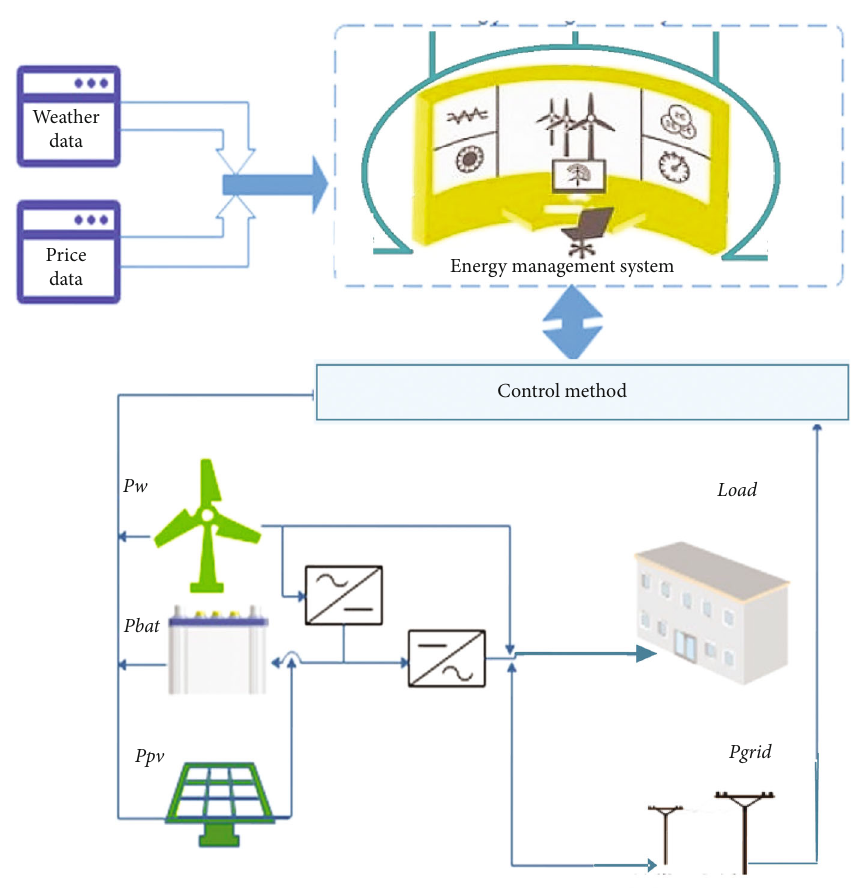
Figure 1: Structure of the proposed hybrid system. Table 1: Electricity tari ff for Moroccan domestic use [27]. Consumption range per